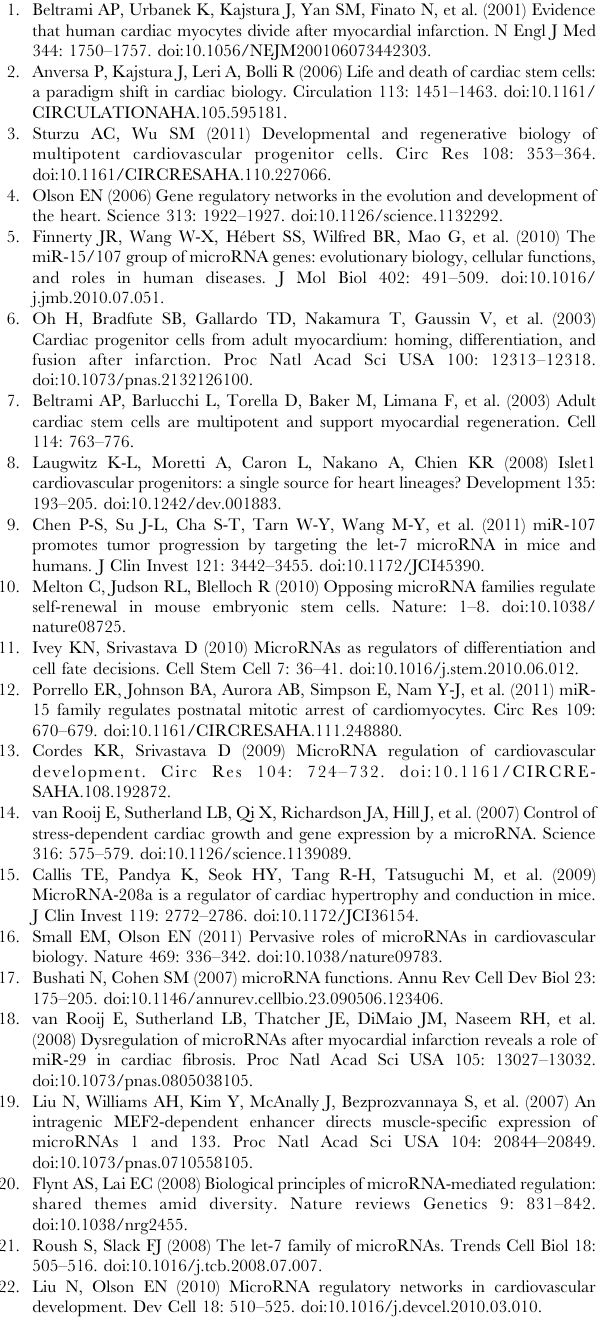
Table S1 Raw and normalized qPCR data for miR expression profiles in mouse adult cardiac stem cells (CSC), bonemarrow lin negative, c-kit positive immature bone marrow stem cells (BM) and mouse embryonic heart (EMB). Excel file, two